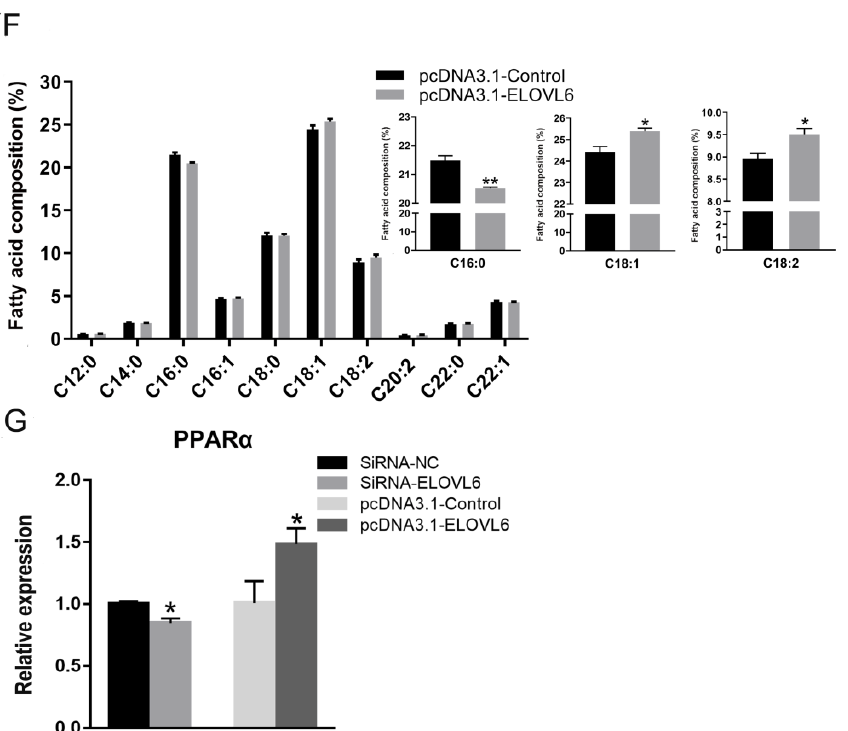
Figure 4. Elongase of very long chain fatty acids 6 (ELOVL6) promotes fatty acid elongation in C2C12 cells. ( A ) Detection of ELOVL6 mRNA expression in C2C12 cells by qPCR following transfection with siRNA-ELOVL6 or negative control (NC) for 24 h. ( B ) Detection of ELOVL6 protein expression in C2C12 cells by Western blotting following transfection with siRNA-ELOVL6 or NC. Ratios represent the densitometry value of the treatment group compared to that of the control group. ( C ) Detection of ELOVL6 mRNA expression in C2C12 cells by qPCR following transfection with pcDNA3.1 ELOVL6 or pcDNA3.1 control. ( D ) Detection of ELOVL6 protein expression in C2C12 cells by Western blotting following transfection with pcDNA3.1 ELOVL6 or pcDNA3.1 control. Ratios represent the densitometry value of the treatment group compared to the control group. ( E ) Fatty acid composition was measured after C2C12 cells had been transfected with siRNA-ELOVL6 or NC for 24 h.